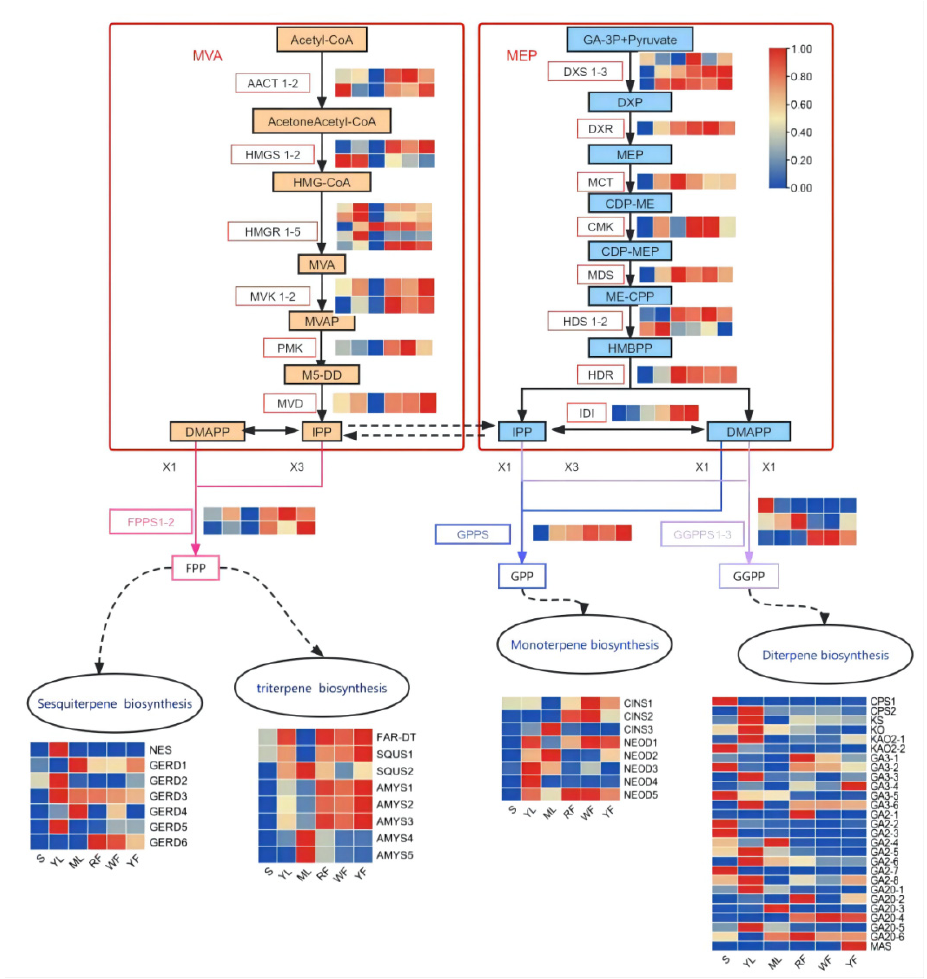
Figure 5. DEGs in terpenoid biosynthesis of sacred lotus. Typical terpenoid biosynthetic pathway with homology heat map of gene transcription level in transcriptome data with substrates and prod- ucts. The arrows connect the substrate to their corresponding product. The expression pattern of each unigene is displayed in a six-column grid; from left to right are seed, young leaf, mature leaf, red flower, white flower, and yellow flower. Transcript-level data is represented by FPKM. AACT , Acetyl-CoA C-acetyltransferase; HMGS, hydroxymethylglutaryl-CoA synthase; HMGR, hydroxymethylglutaryl-CoA reductase (NADPH); MVK, mevalonate kinase; PMK, phosphomevalonate kinase; MVD, diphos- phomevalonate decarboxylase; DXS, 1-deoxy-D-xylulose-5-phosphate synthase; DXR, 1-deoxy-D-xylulose-5-phosphate reductoisomerase; MCT, 2-C-methyl-D-erythritol 4-phosphate cytidylyltransferase; CMK, 4-diphosphocytidyl-2-C-methyl-D-erythritol kinase; MDS, 2-C-methyl-D- erythritol 2,4-cyclodiphosphate synthase; HDS, (E)-4-hydroxy-3-methylbut-2- enyl-diphosphatesynthase; HDR, 4-hydroxy-3-methylbut-2-en-1-yl diphosphate reductase; IDI, isopentenyl-diphosphate Delta-isomerase; DMAPP, dimethylallyl diphosphate; GPPS, geranyl diphosphate synthase; FPPS, farnesyl diphosphate synthase; GGPPS, geranylgeranyl diphosphate synthase; NRS, (3S,6E)-nerolidol synthase; GERD, (-)-germacrene D synthase; FAR-DT, farnesyl-diphosphate farnesyltransferase; SQUS, squalene monooxygenase; AMYS, beta-amyrin synthase; CINS, 1,8-cineole synthase; NEOD, (+)-neomenthol dehydrogenase; CPS, ent-copalyl diphosphate synthase; KS, ent-kaurene synthase; KO, ent-kaurene oxidase; KAO2, ent-kaurenoic acid oxidase 2; GA3, gibberellin 3-beta-dioxygenase; GA2, gibberellin 2-oxidase; GA20, gibberellin 20-oxidase; MAS, momilactone-A synthase.